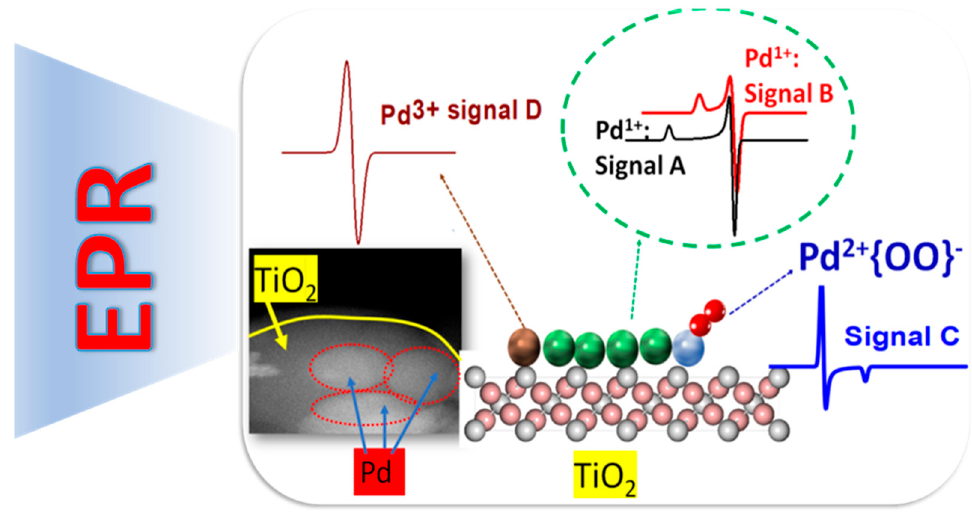
Figure 11. Detection techniques of different Pd species. Adapted from [25] with permission.